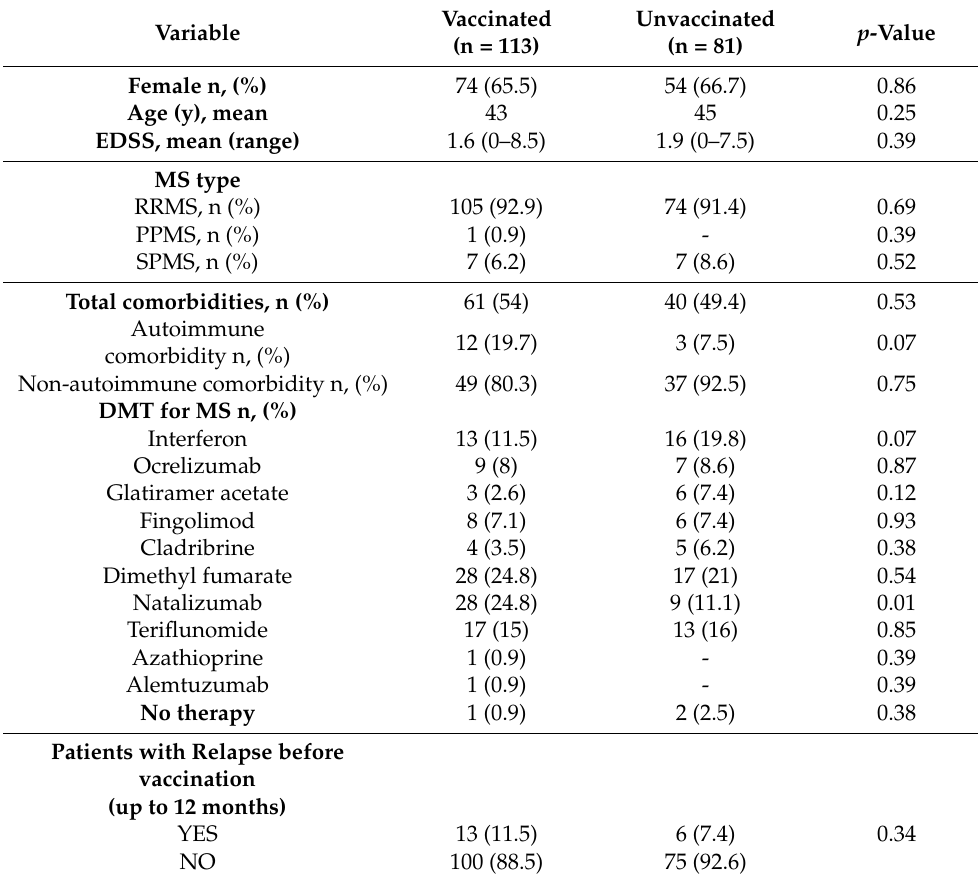
Table 2. The sample divided in a vaccinated and unvaccinated group.